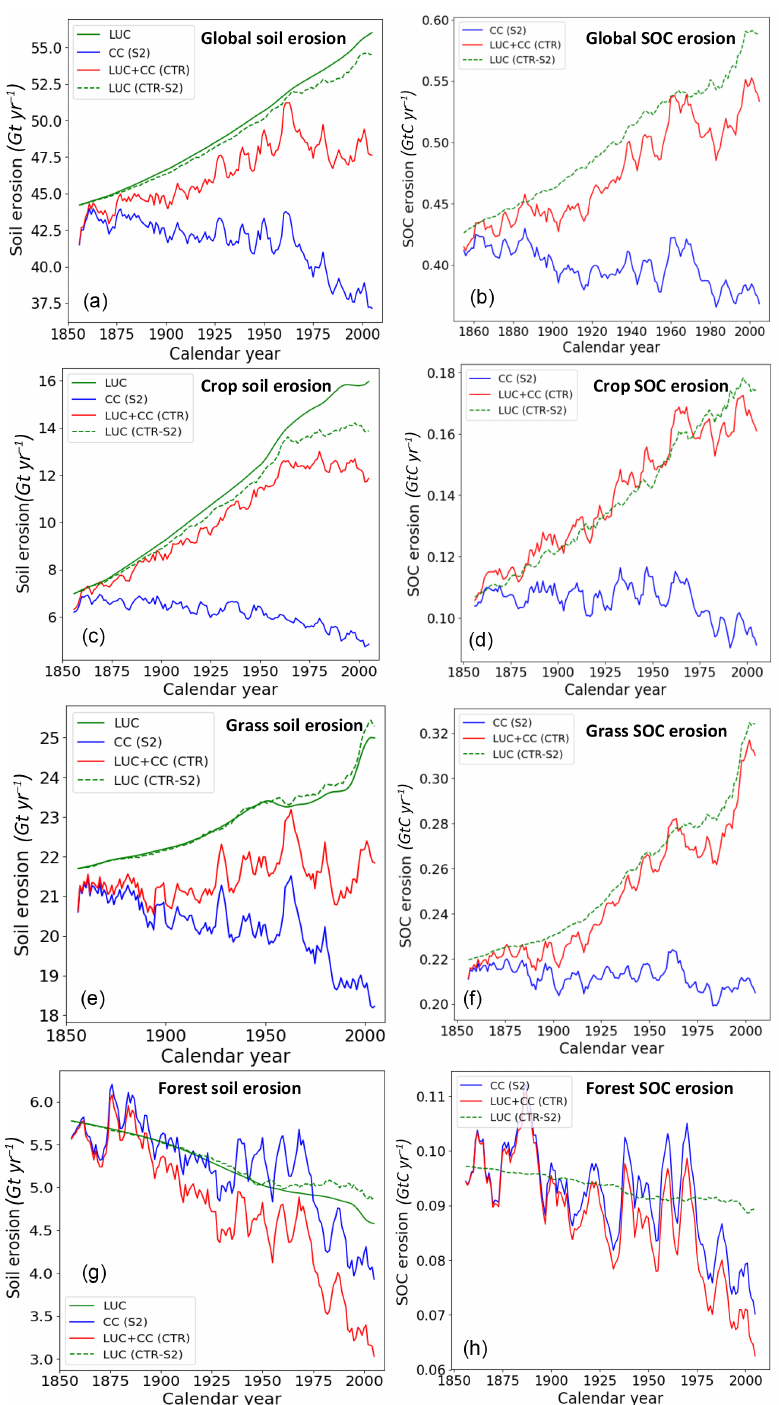
Figure 4. (a) Global annual soil erosion rates, (b) global annual SOC erosion rates, (c) agricultural annual soil erosion rates, (d) agricultural annual SOC erosion rates, (e) grassland annual soil erosion rates, (f) grassland annual SOC erosion rates, (g) forest annual soil erosion rates, and (h) forest annual SOC erosion rates over the period 1850–2005 for scenarios with only LUC (green lines), the scenario with only climate and CO 2 change (blue line), and the scenario with LUC, climate, and CO 2 change (red line). In (a) , (c) , (e) , and (g) the dashed green line is the difference between the CTR and S2 simulations, while the straight green line is the LUC-only simulation with the Adj.RUSLE